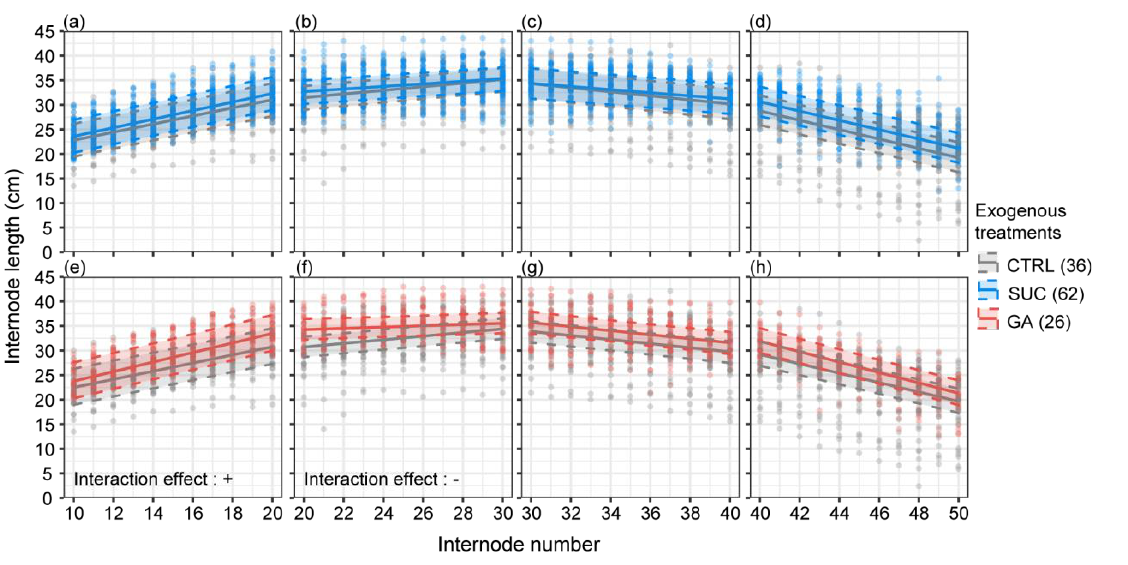
Figure 4. The effect of the interaction between exogenous treatments and internode number on the internode length. The points represent the measured values of the internode length. The shaded intervals within the dashed lines show the 95% Bayesian credible intervals. The numbers in brackets represent the sample sizes ( a – h ). The symbols + or − mean a significant positive interaction or negative interaction, respectively.